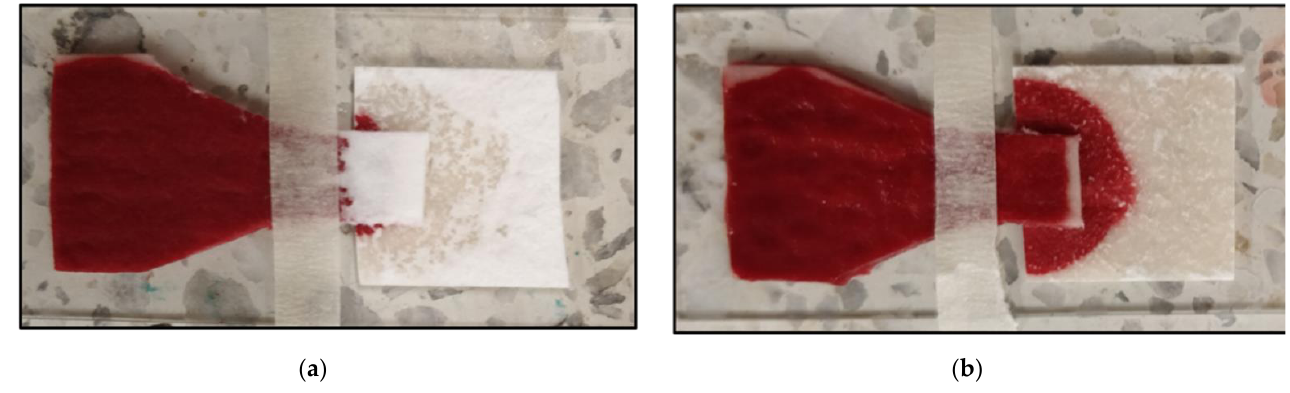
Figure 6. The behavior of BPS device with whole blood volumes below and above 300 µ L: ( a ) 275 µ L of whole blood; ( b ) 325 µ L of whole